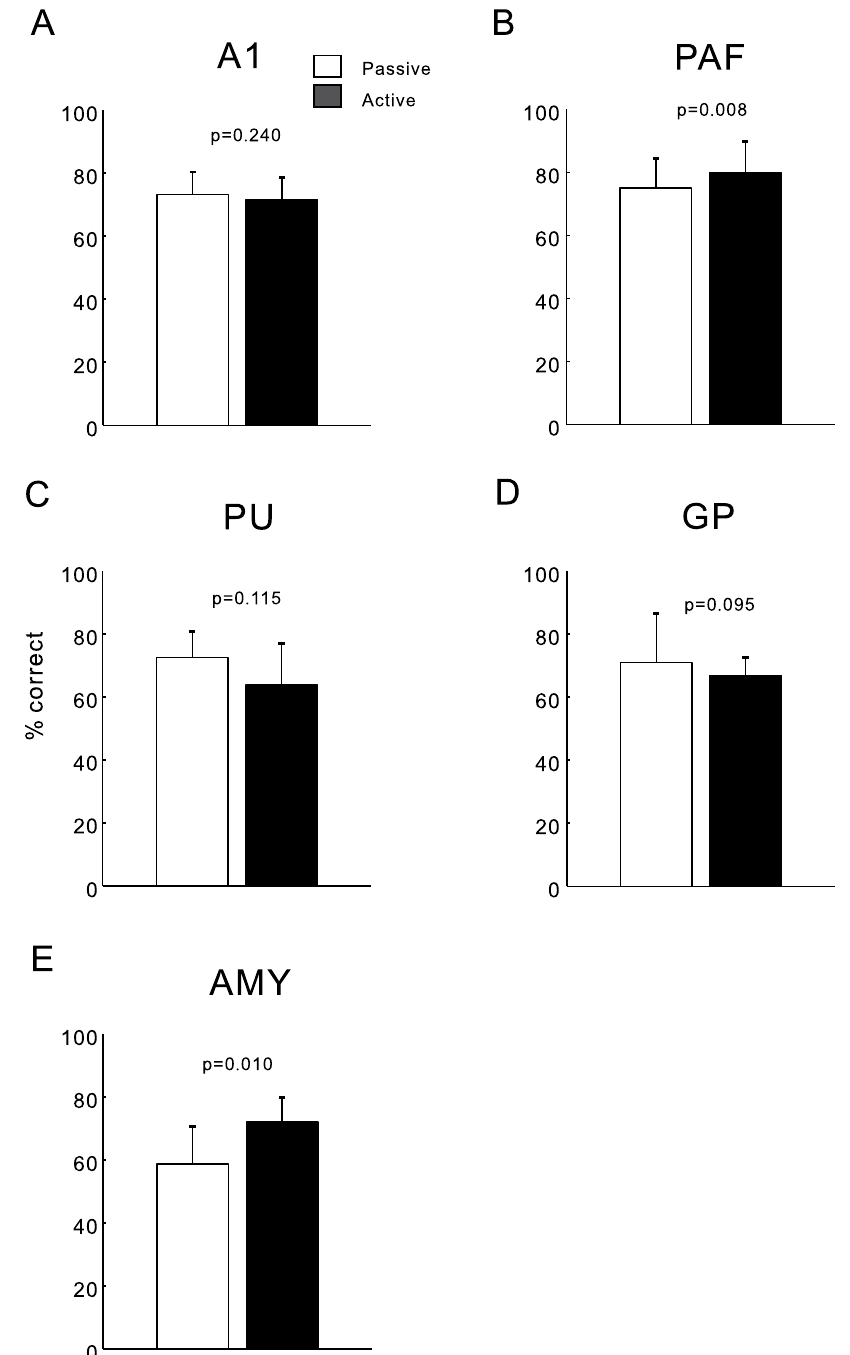
Figure 8. Comparison of accuracy of tone detection based on the neural spikes of active and passive sessions. Conventions are as described in Fig.